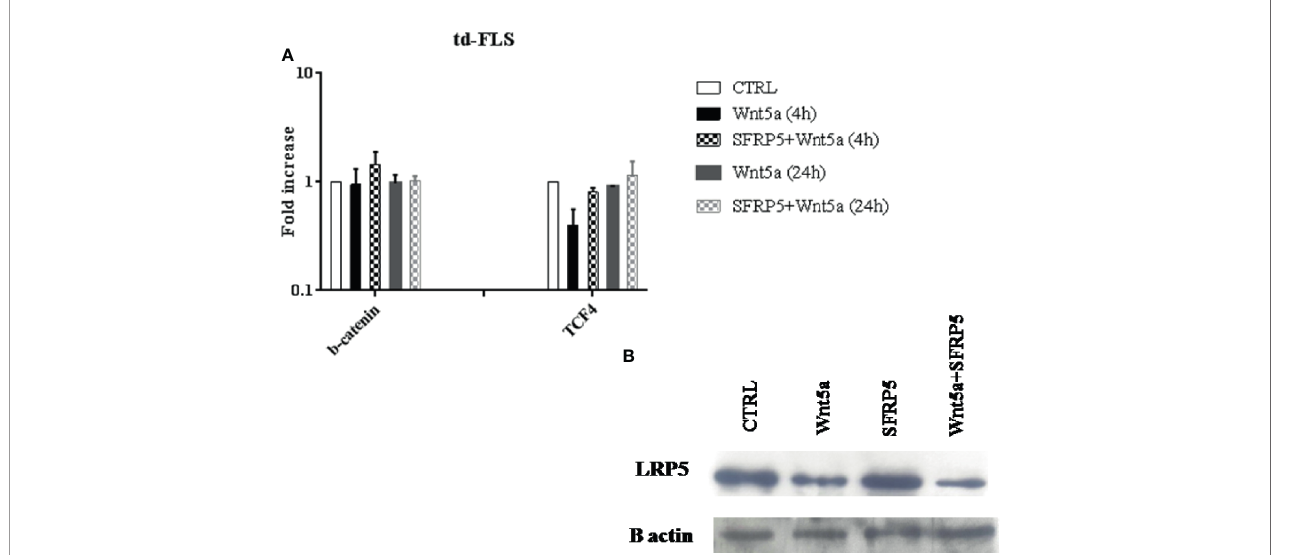
FIGURE 7 | Effect of Wnt5a on the canonical Wnt pathway activation in RA td-FLS. RA td-FLS (passage 3) were stimulated with recombinant Wnt5a (300 ng/ ml) in the presence or absence of SFRP5 (1 mg/ml) for 4 h and/or 24h. Intracellular regulator expression pro fi les ( b - catenin and TCF4) were determined in cell culture using qPCR (A) . Gene expression levels in unstimulated cells were assumed to be 1. Results are shown as the mean ± SD of two independent experiments each performed in triplicates using at least two different lots of each of the recombinant Wnt proteins. The protein abundance of LRP5 was studied by Western blot analysis after 24h of stimulation (B) . The Western blot is representative of one experiment out of